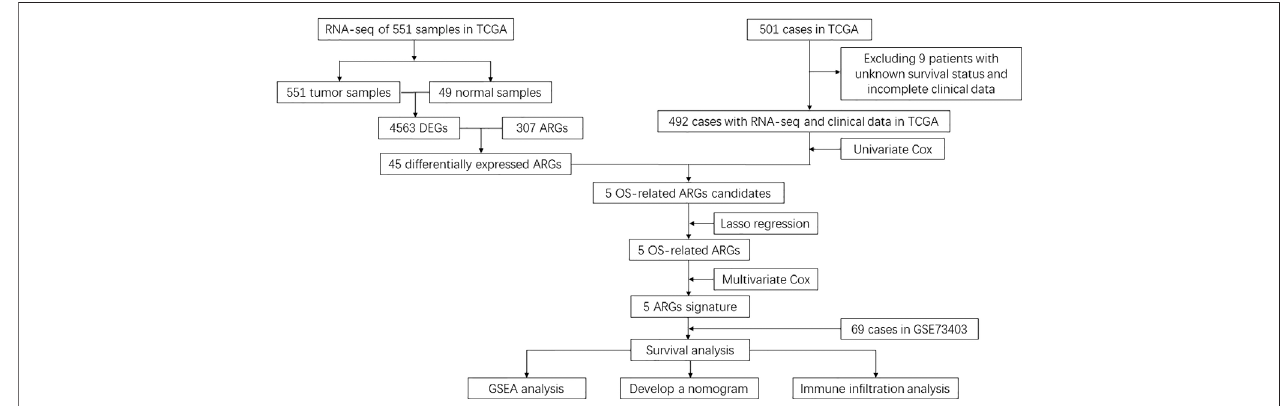
FIGURE 1 | Flowchart of data collection and analysis.